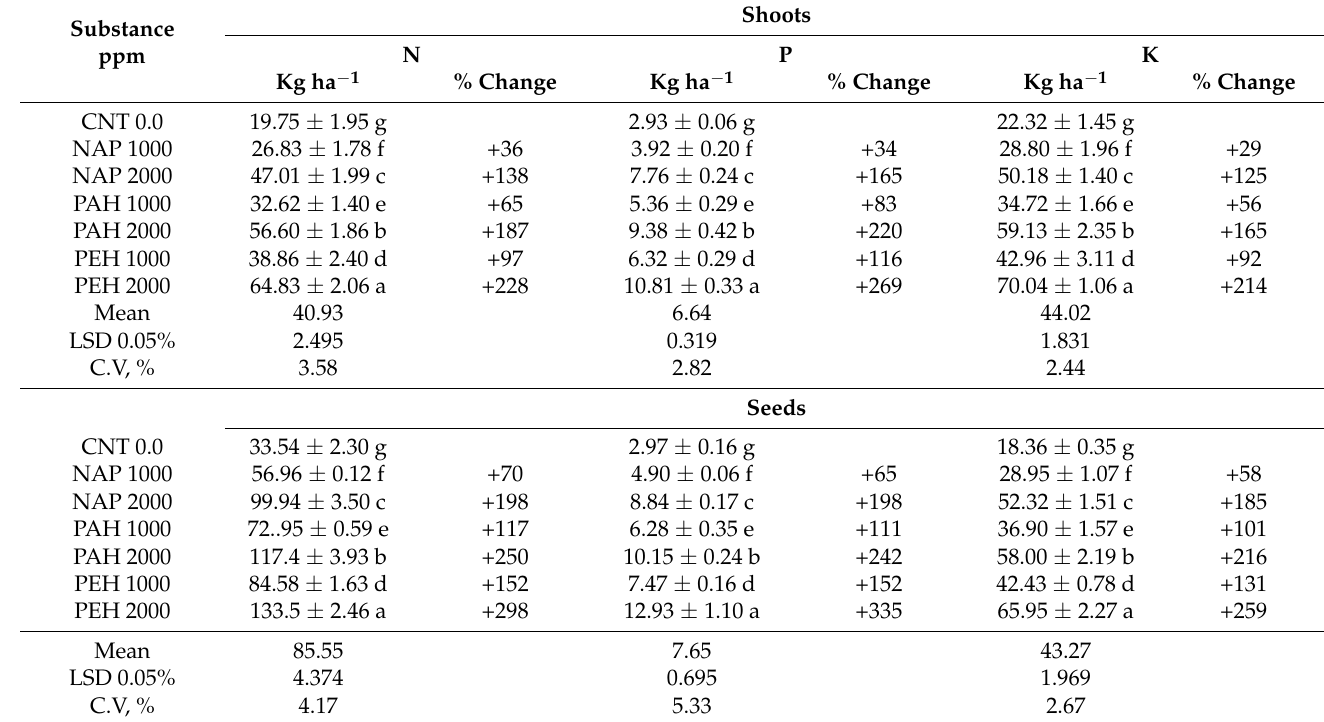
Table 3. N, P and K-uptake of Pisum sativum plants under normal clay loam soil conditions, as treated with foliar spray of native whey protein (NAP), papain-hydrolyzed whey protein (PAH) or pepsin-hydrolyzed whey protein (PEH) at two different concentrations; 1000 and 2000 mg L − 1 , as compared to the normal control (CNT).